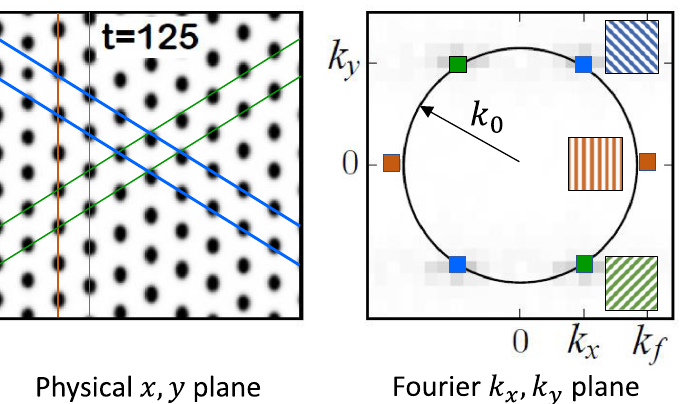
Fig 4. Self-organized (SO) modes associated with rhombic pattern. A nearly asymptotic rhombic pattern in the ( x , y ) plane (left), resulting from an instability of a stripe pattern, and the corresponding Fourier plane ( k x , k y ) showing the three SO modes that comprise it (right). See Fig A in S1 Appendix for earlier snapshots. These modes include the original stripe mode with wave-vectors ± ( k , 0) (red squares in right panel), representing periodicity in the x direction f as the inset with vertical red stripes in the right panel show. The signature of this mode in the rhombic pattern (left panel) is illustrated by the red lines. The two additional SO modes are a pair of oblique modes with wave- vectors ± ( k f /2, k y ) and ± ( k f /2, − k y ) (blue and green squares, respectively, in right panel), which represent slanted stripe patterns as the insets in blue and green in the right panel show. The wave-vector component k is determined such that y the corresponding wave-vector sits on a circle of radius k 0 —the wavenumber (periodicity) that the natural pattern (in the absence of ground modulations) tends to form. The signatures of the oblique modes in the rhombic pattern (left panel) are illustrated by the slanted blue and green